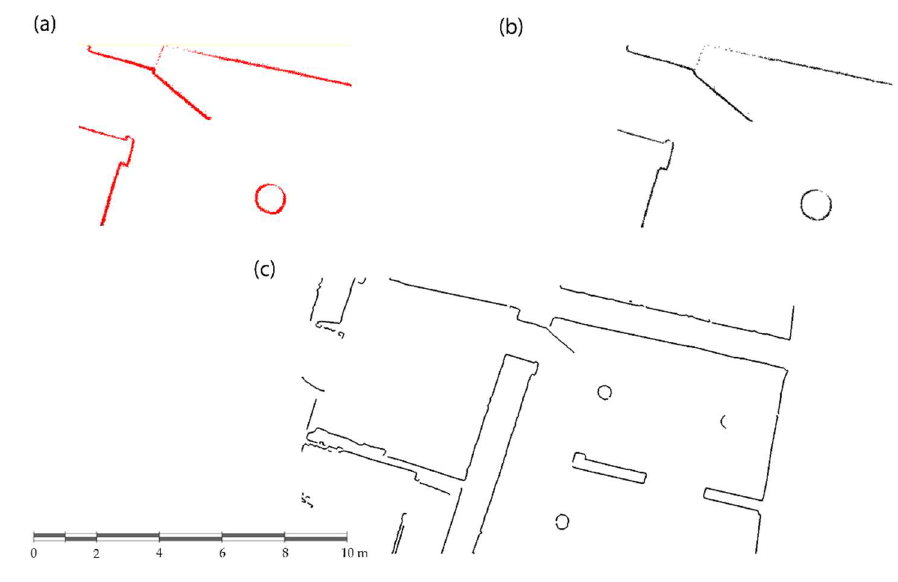
Figure 16. Detail of the vectorization process: ( a ) section extracted from the point cloud; ( b ) section filtered; ( c ) application of the least-cost-algorithm over the filtered section.